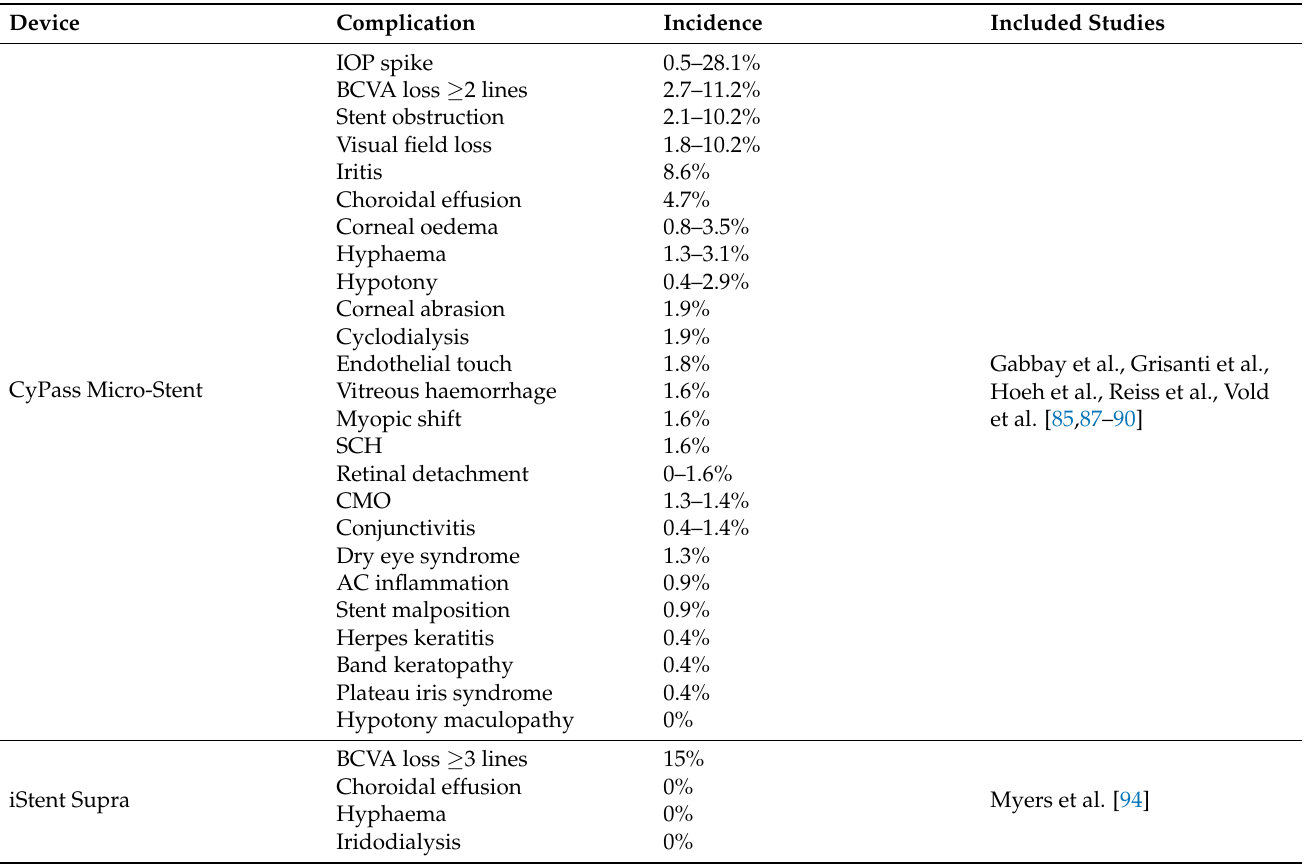
Table A2. Complication Rates of Devices Enhancing Aqueous Outflow Through the Suprachoroidal Space.